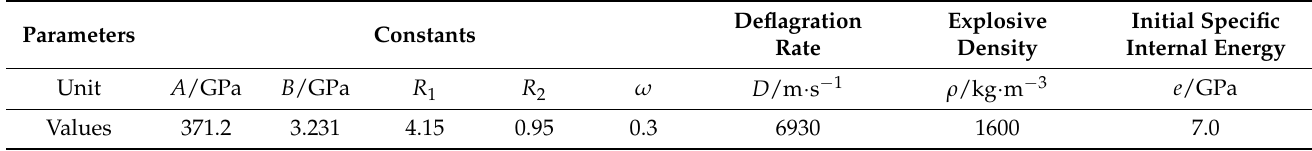
Table 2. Parameters in the JWL state equation.